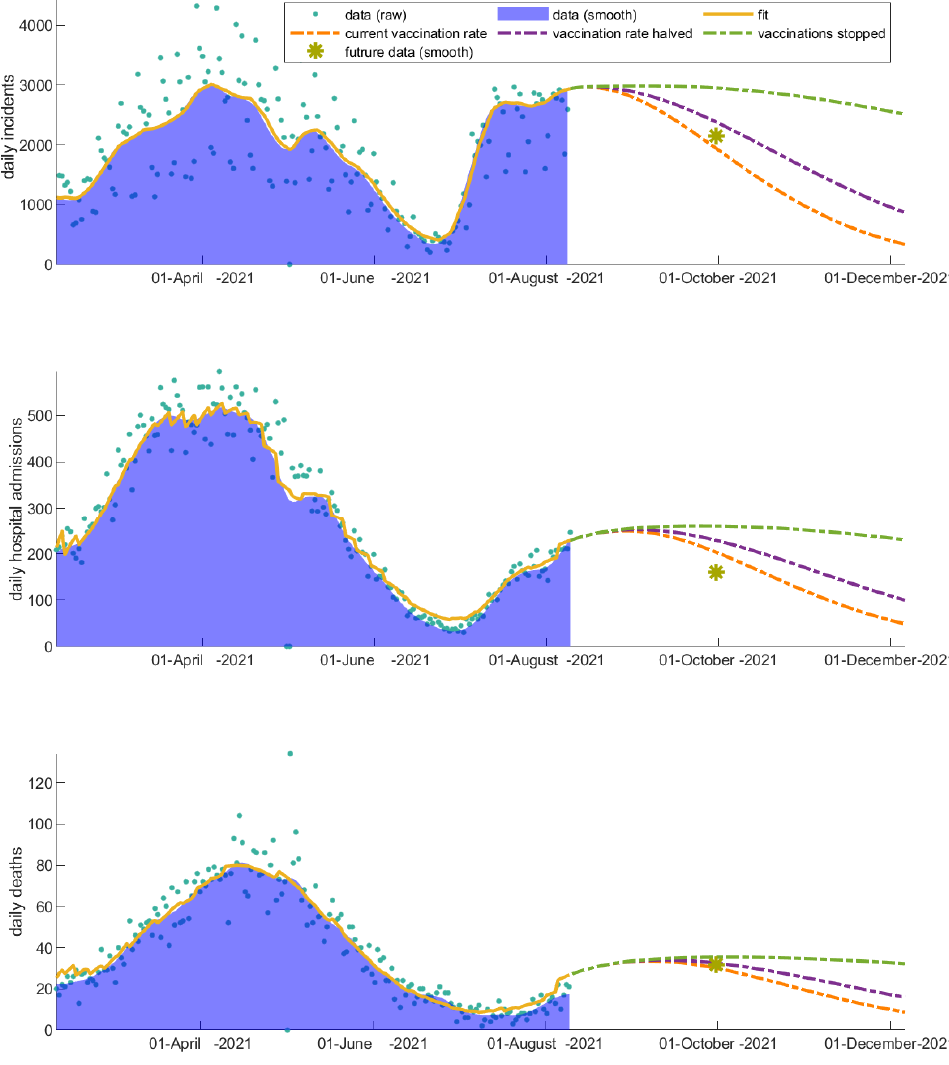
Figure 4. Impact of altering the vaccination rate after 10 August 2021 (rise of the third wave in Greece) on disease dynamics. The daily (a) incidents, (b) hospital admissions, and (c) deaths are affected indicating the importance of keeping up the high vaccination pace. An indicative data point from the future (1 October 2021) is shown with a yellow asterisk for